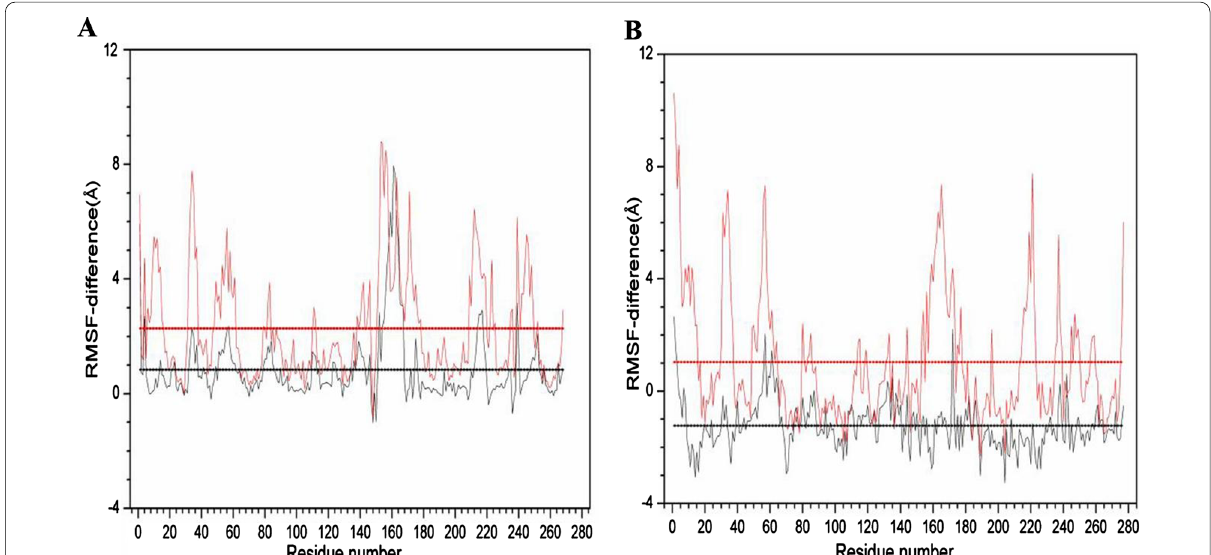
Fig. 6 The RMSF-DIFF as a function of residue number in 1URX ( A ) and 3WZ1 ( B ). The black broken line indicates that the RMSF values of 400 K subtracted from the corresponding profile of 300 K, and the thick black lines are their averages. The broken red line indicates that the RMSF values of 500 K subtracted from the corresponding profile of 300 K, and the thick red lines are their averages